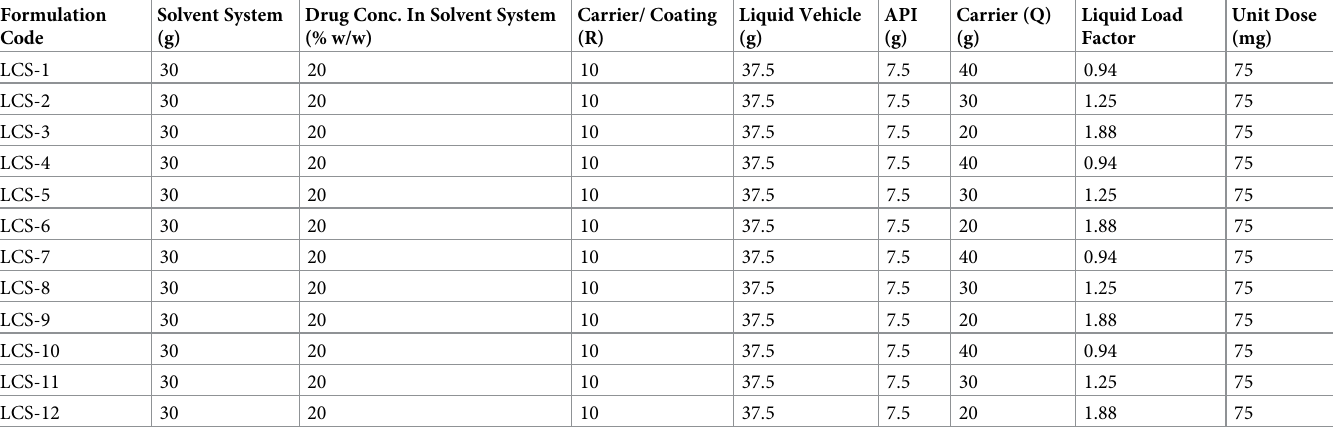
Data has been rounded off to two digits after decimal